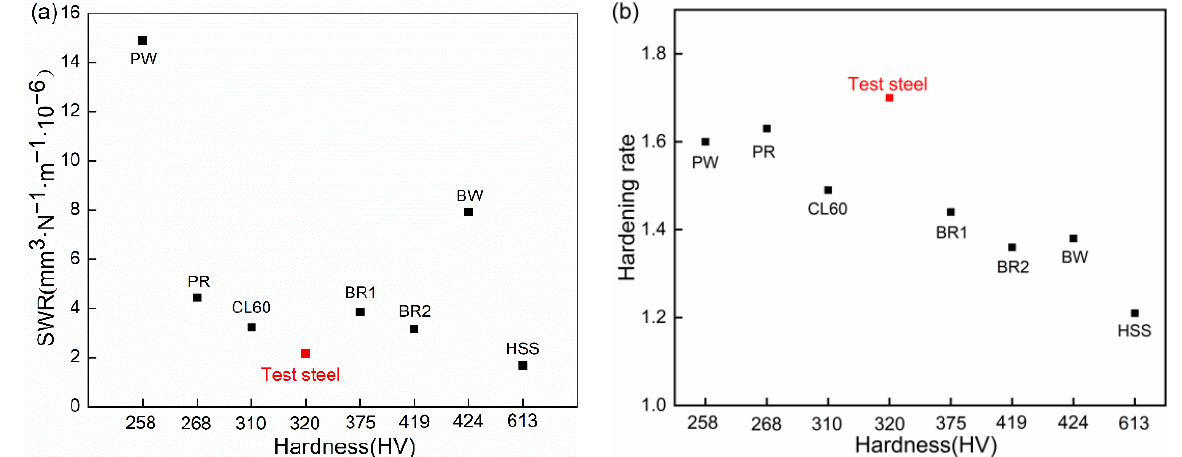
Figure 14. ( a ) Wear resistance and ( b ) hardening rate of materials in railway reported.